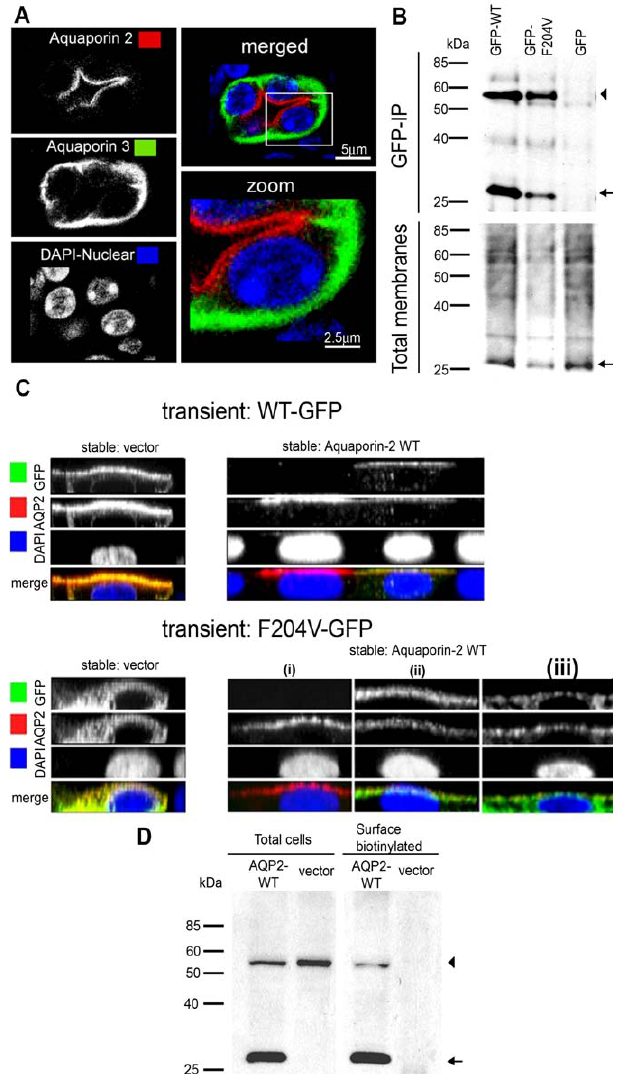
Figure 5. AQP2-F204V Rescue in Heterozygous Mouse Collecting Ducts and in Cotransfected MDCK Cells (A) In heterozygous animals, AQP2 localizes and responds to dDAVP normally. Immunohistochemistry was carried out on kidney sections from an Aqp2 F204V/ þ mouse, after injection with dDAVP. Kidney sections were sequentially immunostained for AQP2 (red) and the basolateral marker AQP3 (green). (B) Mutant and wild-type AQP2 physically interact. MDCK cells stably expressing wild-type AQP2 were transiently transfected with GFP tagged wild-type AQP2, AQP2-F204V, or GFP alone. Solubilized membranes were immunoprecipitated with a GFP antibody. Total membranes and immunoprecipitates (GFP-IP) were Western blotted using an antibody against AQP2 (arrow) or AQP2-GFP fusions (arrowhead). (C) Wild-type AQP2 rescues the localization defect of mutant AQP2. GFP fusions of either wild-type AQP2 (WT-GFP, top photomicrographs) or F204V AQP2 (F204V-GFP, bottom photomicrographs) were expressed in polarized MDCK stable cell lines expressing vector alone (vector, left photomicrographs) or AQP2-WT (right photomicrographs). Cells were stimulated with forskolin, processed for immunocytochemistry, and used to generate z-sectional images. (D) Mutant AQP2 is present at the cell surface in cells coexpressing wild- type AQP2 (AQP2-WT). GFP fused to AQP2-F204V was expressed in MDCK cells expressing wild-type AQP2 or vector alone. Cells were stimulated with forskolin, and cell surface biotinylated proteins were precipitated then analyzed for the presence of wild-type AQP2 (arrow) and AQP2-F204V (arrowhead) by Western blot. DOI: